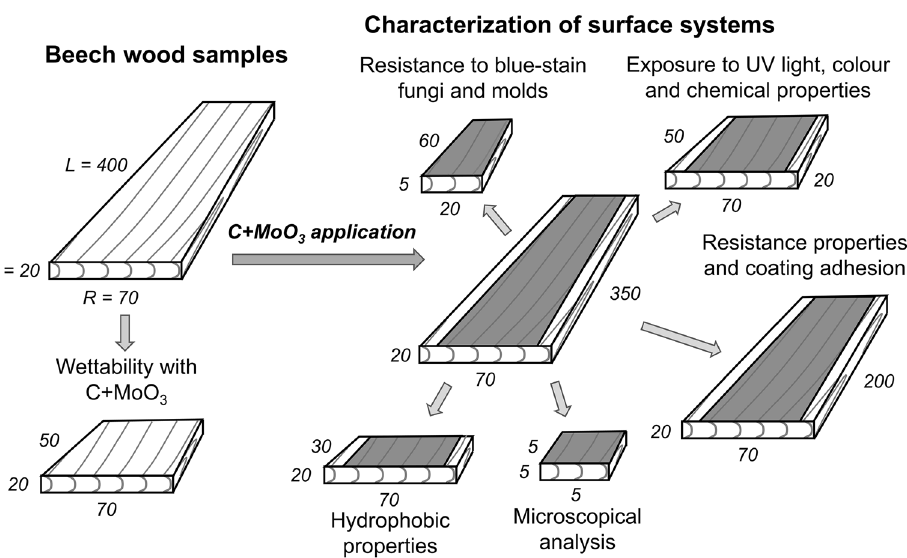
Figure 1. Distribution of wood samples preparation for different studies. The numbers present the sample size in individual wood grain direction (in millimeters): L—longitudinal, R—radial and